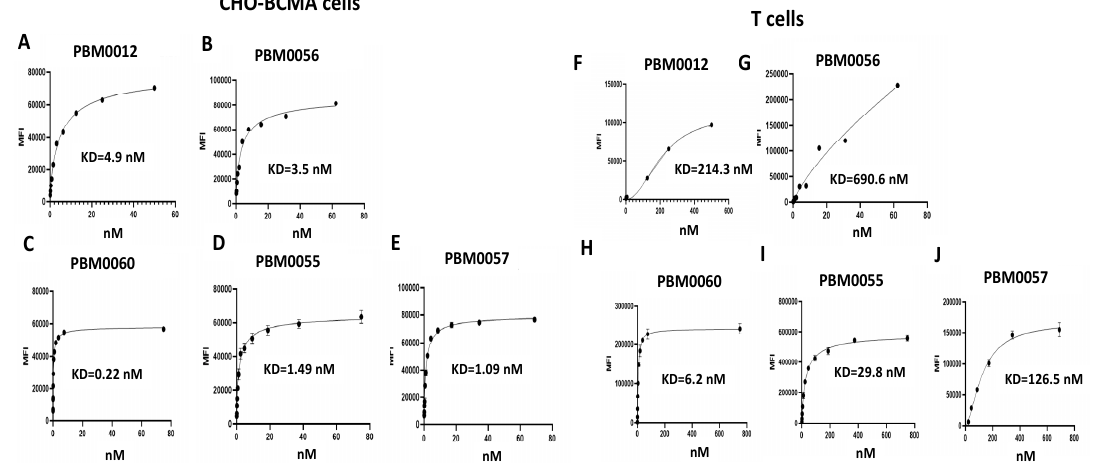
Figure 2. Binding of BCMA-CD3 antibodies to BCMA-positive CHO-BCMA cells and T cells. FACS was performed with all antibodies on BCMA-positive CHO-BCMA cells ( A – E ), and T cells ( F – J ). Representative assay is shown.